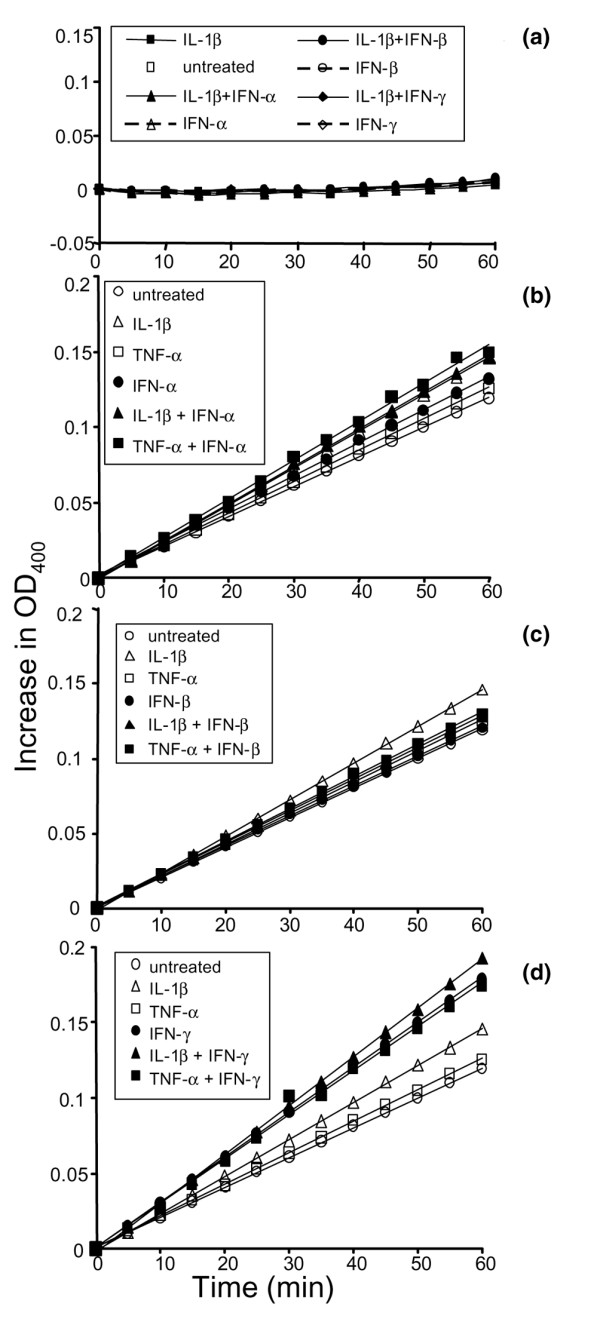
Detection of dipeptidyl peptidase IV activity. (a) Soluble dipeptidyl peptidase IV (DPP IV) activity in serum-free conditioned medium from fibroblast cultures or (b)–(d) the activity of DPP IV associated with fibroblast membranes was evaluated by detecting the release of p-nitroanilide from GlyPro-p-nitroanilide (increase in UV absorption at 400 nm (OD400) compared with culture medium or untreated cells). Fibroblasts were either left untreated or were treated with the cytokines IFN-α (1000 U/ml), IFN-β (1000 U/ml), IFN-γ (200 ng/ml), IL-1β (10 U/ml) or tumour necrosis factor alpha (TNF-α) (10 ng/ml), or combinations thereof. A significantly increased membrane-bound DPP IV activity was detected on fibroblasts treated with IFN-γ (P < 0.0008), with IL-1β + IFN-γ (P < 0.0004) or with TNF-α + IFN-γ (P < 0.002). Statistical analysis for DPP IV activity on cytokine-treated versus untreated fibroblasts (n = 4 for cytokine combinations and n = 8 for individual cytokines) was performed with the Student t test with Bonferroni correction.